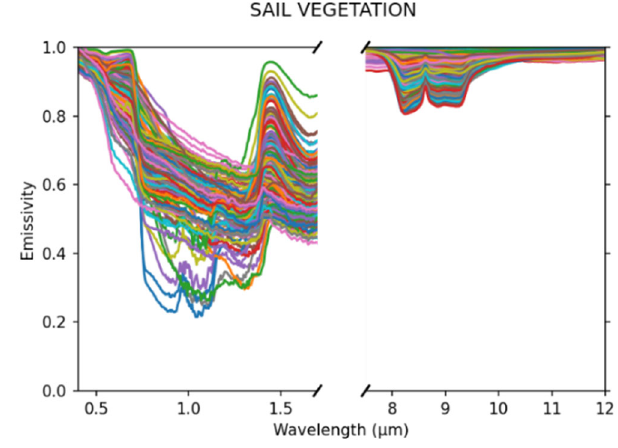
Figure 4. VNIR-SWIR ( left ) and TIR ( right ) Emissivity of the SAIL179 vegetation database.